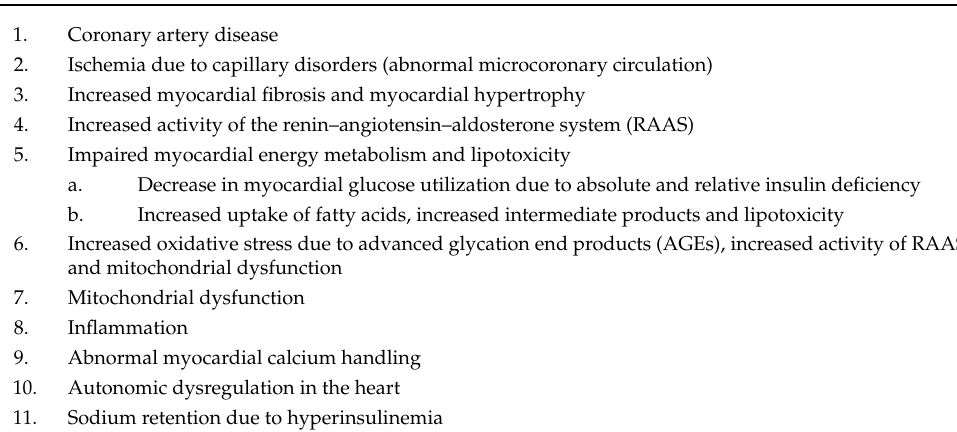
Table 1. Pathogenesis of heart failure associated with